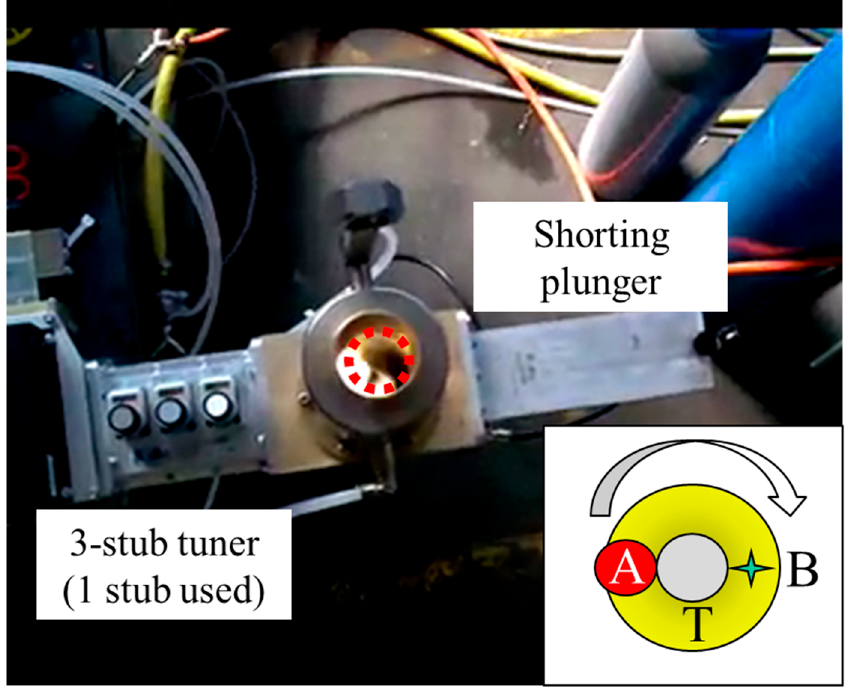
Figure 7. Sketch of the experimental setup for microwave oxy-carburizing: A = the region of the sample directly exposed to the plasma torch; B = pyrometer measurement point; T = oxy-carburized track. Dotted circle = sample position during processing.